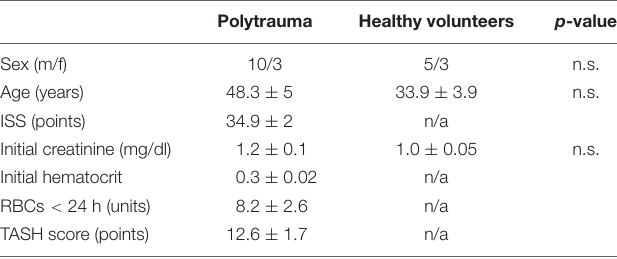
TABLE 1 | Data are shown as mean ± SEM.